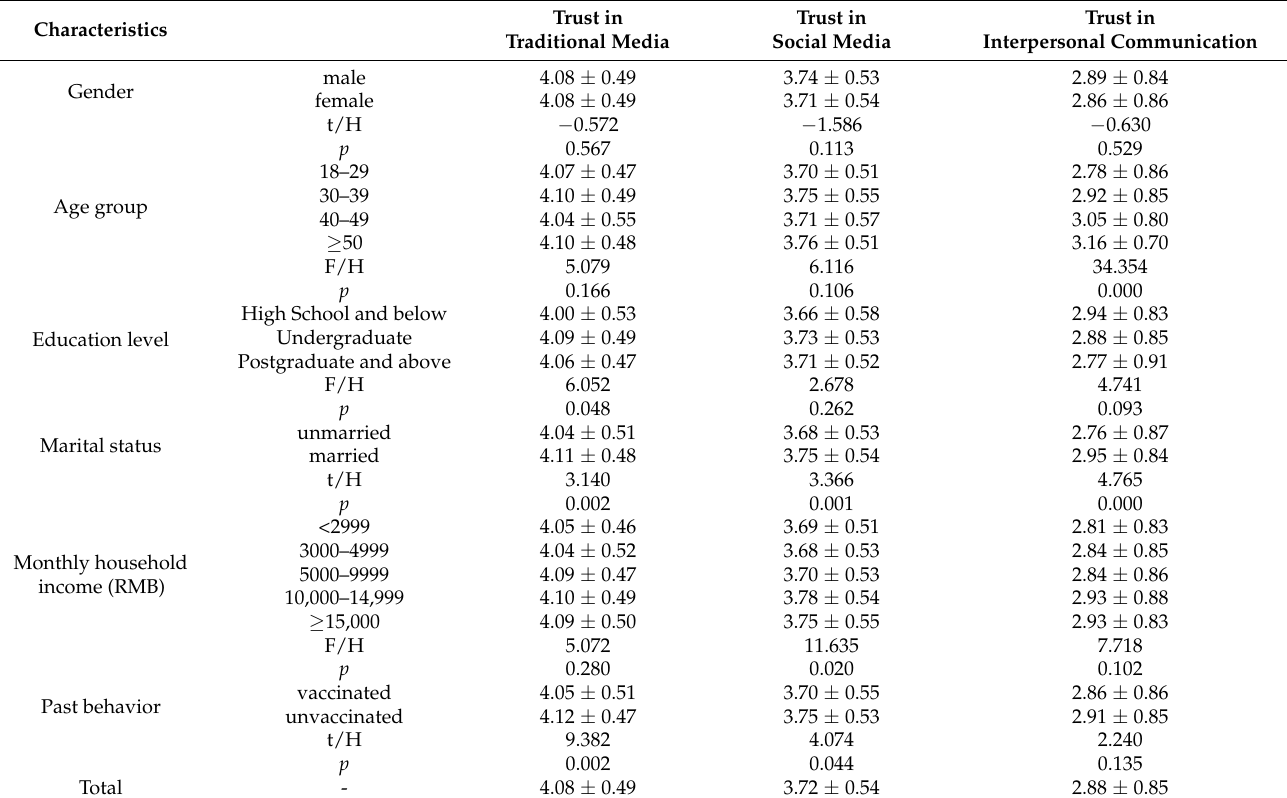
Table 3. Table 3. A monofactor analysis of media trust in